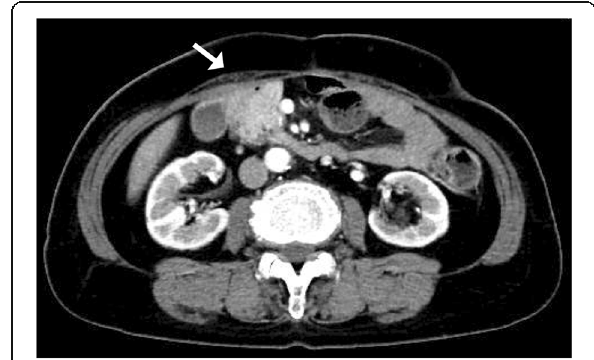
Fig. 4 Contrast-enhanced abdominal CT after chemotherapy showed reduced duodenum tumor and abdominal wall thickness